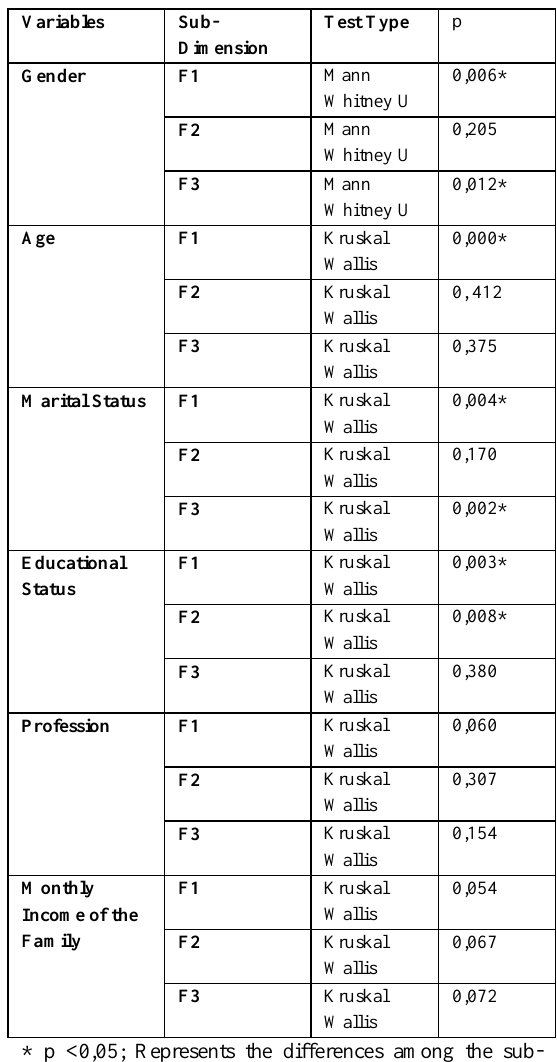
dimensions of Scpgmm